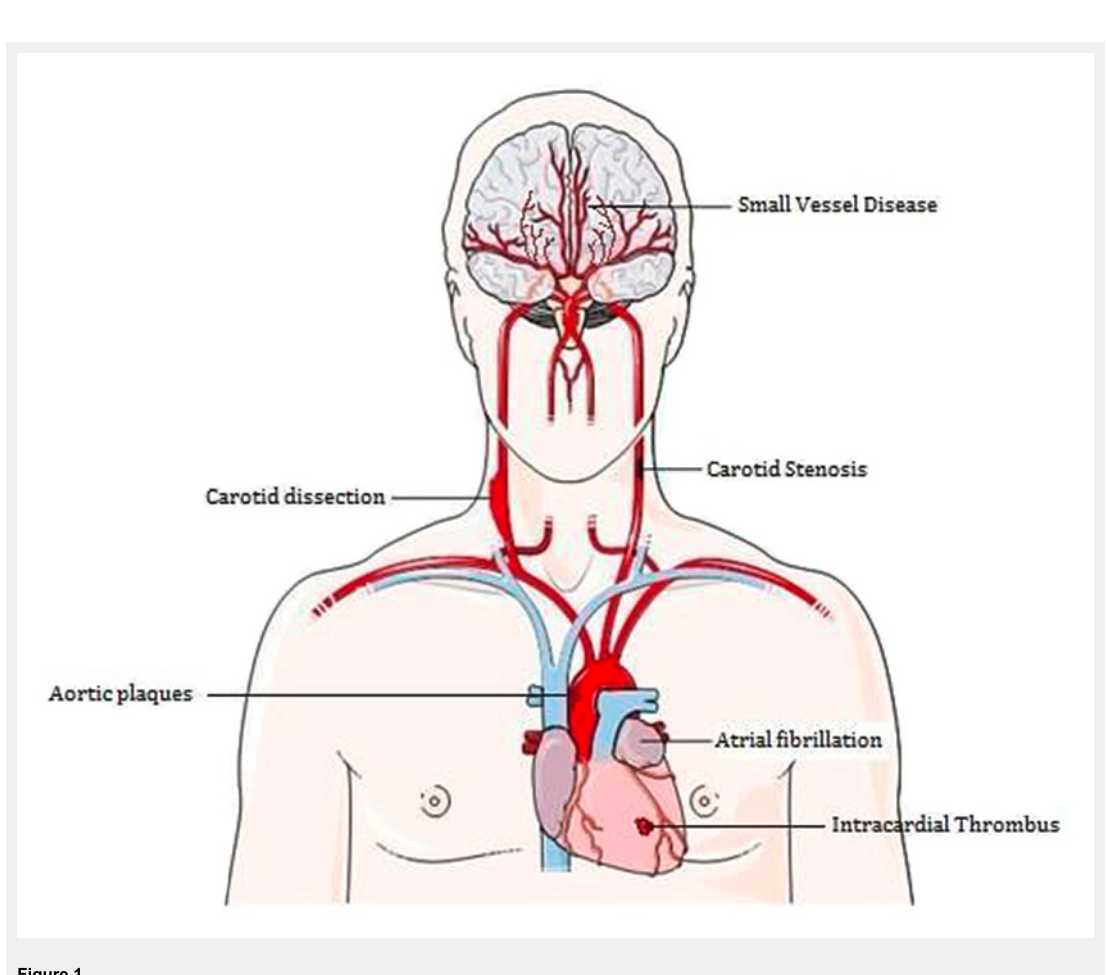
Figure 1 Examples of stroke aetiologies (imaging material adapted from Servier Medical